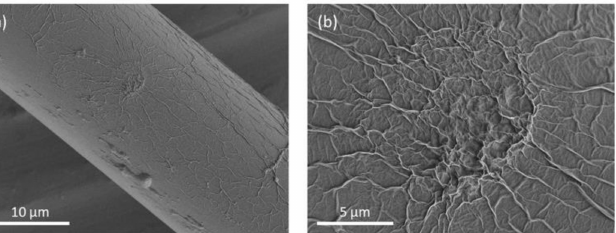
Figure 3. ( a ) Field scanning electron microscope (FESEM) image of GO-coated optical microfiber; ( b ) magnified image of the GO surface.